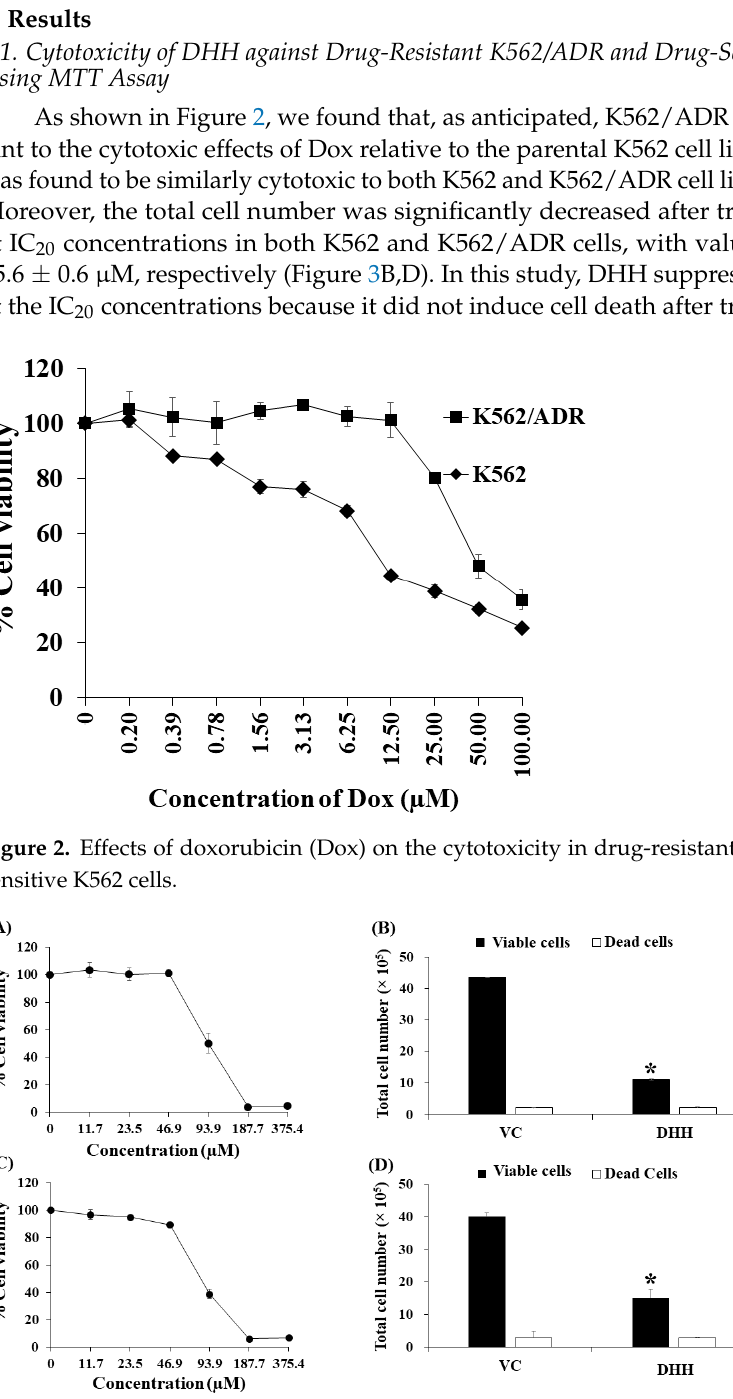
Figure 1. The chemical structure of DHH ( trans -1,7-diphenyl-5-hydroxy-1-heptene).